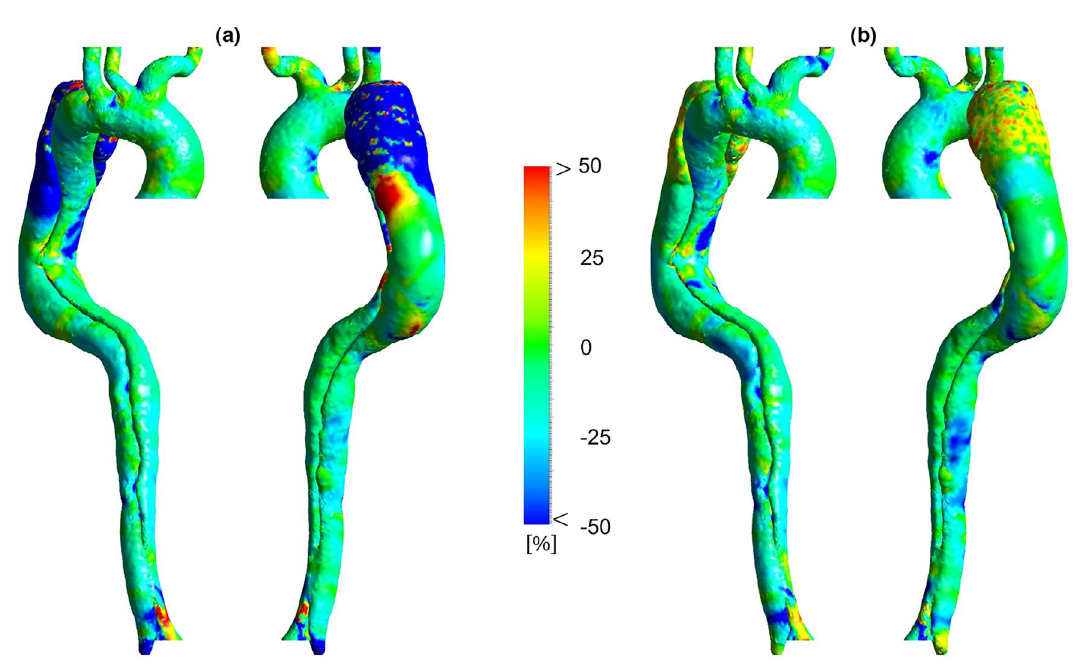
Figure 9. Percentage difference in oscillatory shear index (OSI) according to different heart rates. ( a ) Percentage difference in OSI between 86 and 70 BPM. ( b ) Percentage difference in OSI between 55 and 70